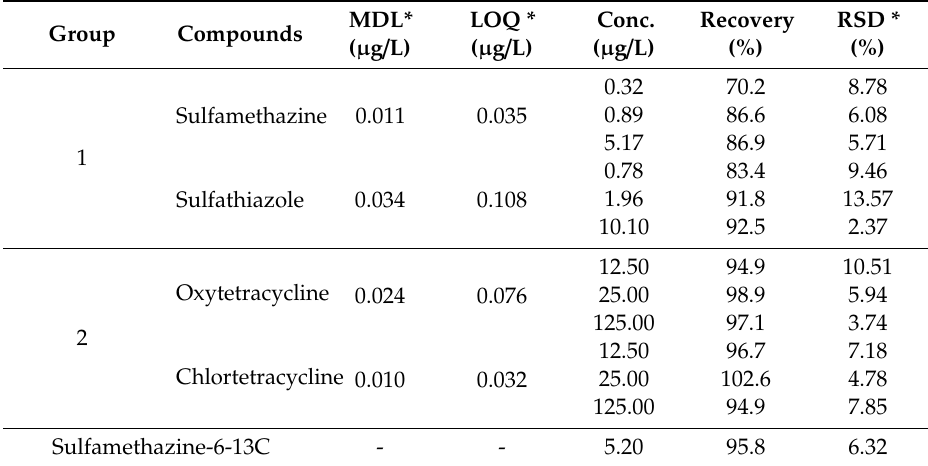
Table 6. Quality control results for di ff erent